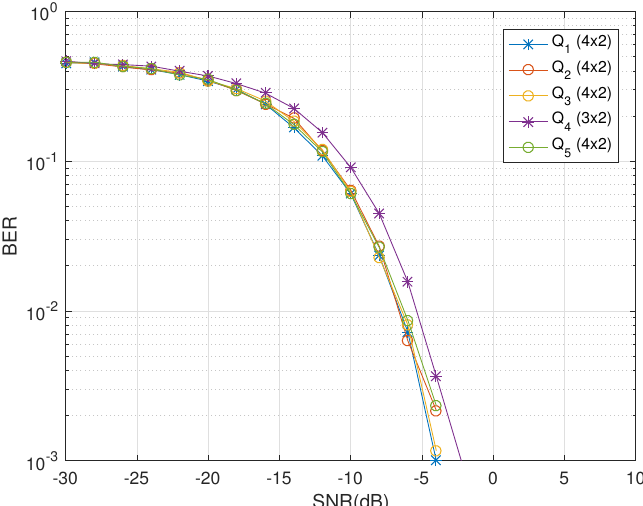
Figure 4. BER vs. SNR performance of Q 1 , Q 2 , Q 3 , Q 4 , Q 5 & Q 6 for two receive dual-polarized antenna.